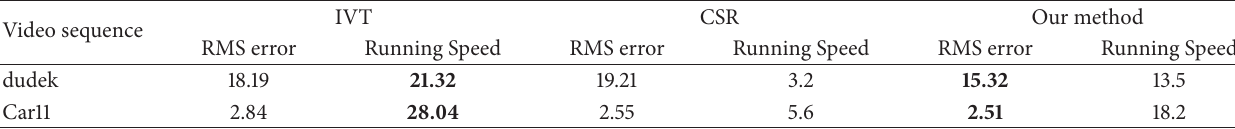
Table 1: Center location RMS errors (in pixel) and running speed (in frame per second) for three trackers. IVT CSR Our method Video sequence RMS error Running Speed RMS